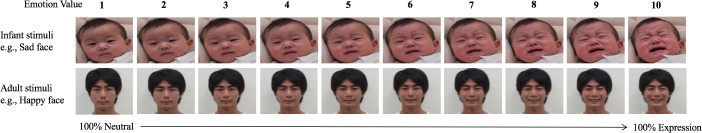
The stimuli of the emotion perception task.